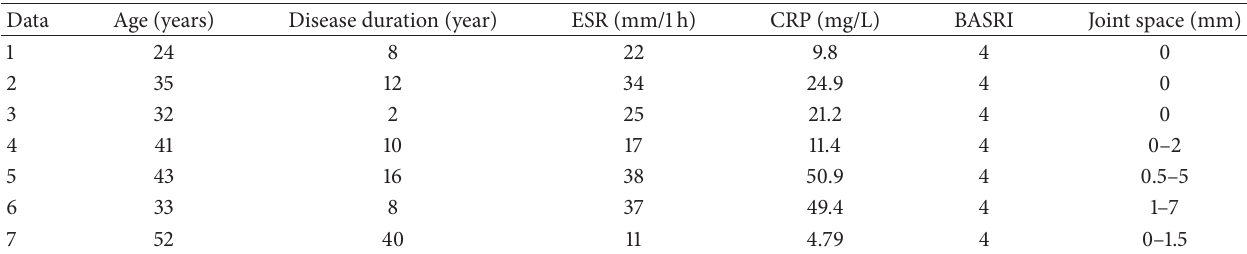
Table 1: Clinical data.